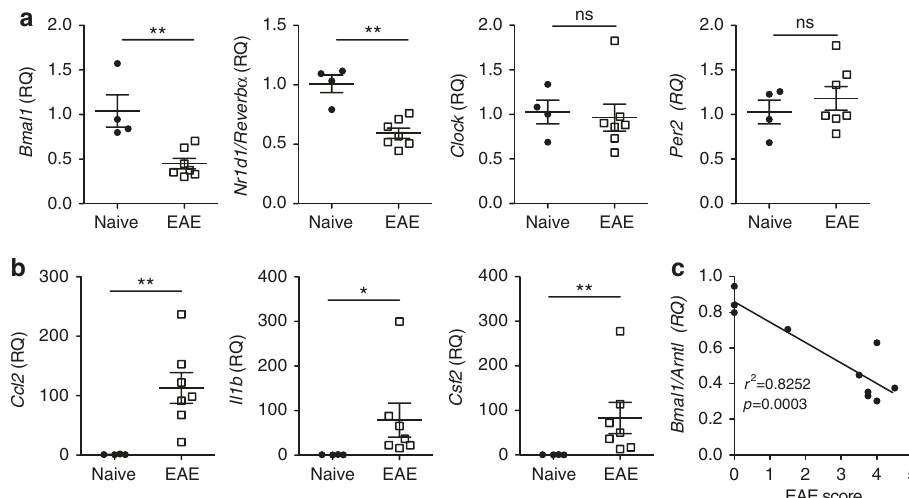
Fig. 5 Dysregulation of Bmal1 and Reverba during the acute disease phase of EAE. a – c Spinal cords were removed from 14 d myelin oligodendrocyte glycoprotein (MOG 35 – 55 ), complete Freund ’ s adjuvant (CFA) and pertussis toxin (PT)-immunized or naive female C57BL/6 mice. a , b RT-PCR analysis of isolated spinal cords ( n = 4 – 6). c Linear regression of clinical scores of 10 mice vs. Bmal1 gene expression in the same animals ( n = 10). Statistics were performed by Mann – Whitney U test ( a – c ). All data presented as means ± standard error of the mean (SEM). RQ relative quanti fi cation.* p < 0.05; ** p <